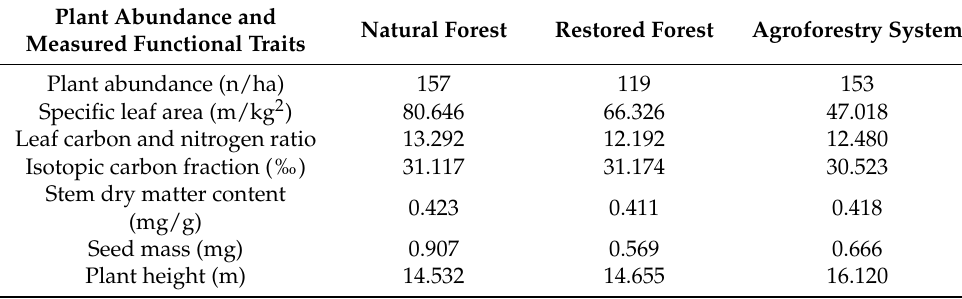
Table A2. Functional trait values (averages) for ecosystem